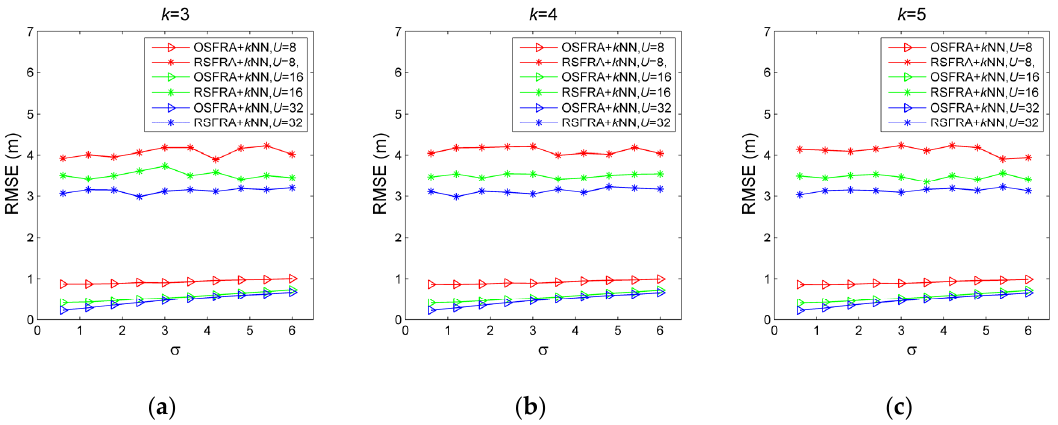
Figure 8. Root mean square error (RMSE) comparison for OSFRA+ k NN and RSFRA+ k NN under various σ , U, and k . ( a ) k =3, ( b ) k =4, and ( c ) k =5.